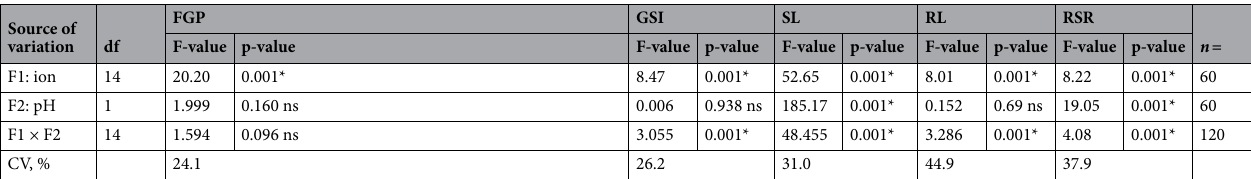
Table 1. Summary of two—way analysis of variance (F and p—values) of germination traits of C. canadensis (final germination percentage; germination speed index) the seedlings traits (seedling and root length, root:shoot ratio) of nutrients and pH levels. *Significant at the p value indicated as error probability level. ns considered not statistically significant at the probability level. df, degree of freedom; n, number of experimental units (treatments × replications); CV, coefficient of variation; FGP, final germination percentage, %; GSI, germination speed index, arbitrary unit; SL, seedling length in their aerial part, mm; RL, root length, mm; RSR, Root:shoot ratio, arbitrary unit.